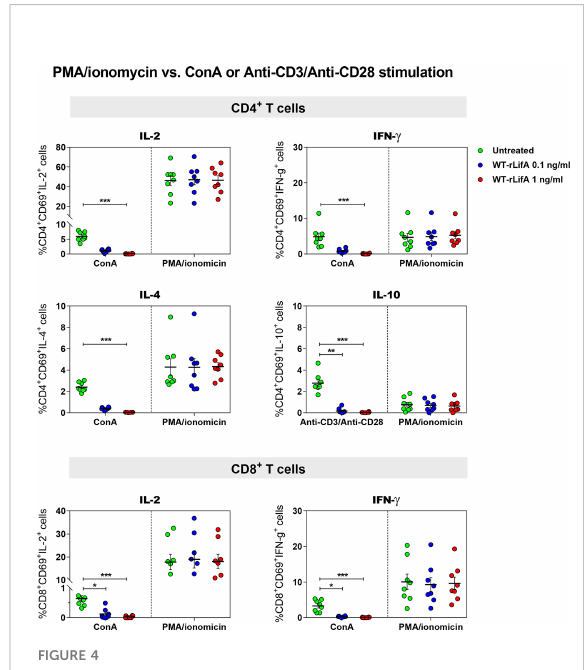
FIGURE 4 Lymphostatin did not inhibit intracellular cytokine production in PMA/ionomycin-stimulated CD4 + and CD8 + T cells. Dot plots show the percentage of CD4 + /CD69 + cells producing IL-2, IFN- g , IL-4, IL-10 and CD8 + /CD69 + cells producing IL-2, IFN- g in the presence of WT-rLifA or left untreated (cells with mitogen; no tested protein) and compared between anti-CD3/anti-CD28 and PMA/ionomycin stimulation. Data represent the mean from 8 healthy donors ± S.E.M. * p < 0.05, ** p < 0.01, *** p < 0.001 using Kruskal-Wallis test followed by Dunn ’ s